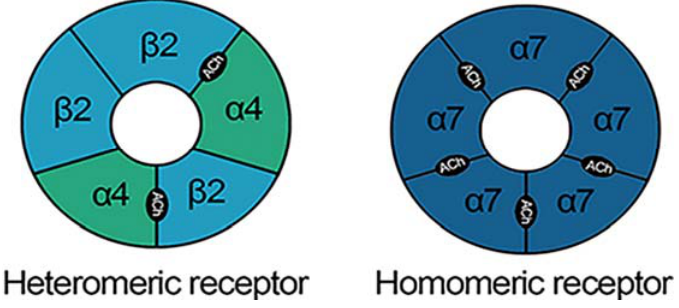
Figure 2. Nicotinic acetylcholine receptors (nAChRs) consist of different combinations of alpha (  ) and beta (  ) subunits. Variations in the subunit composition not only determine the number of binding sites for their endogenous ligand, acetylcholine (ACh) but also the functional properties of the receptor. Taken from